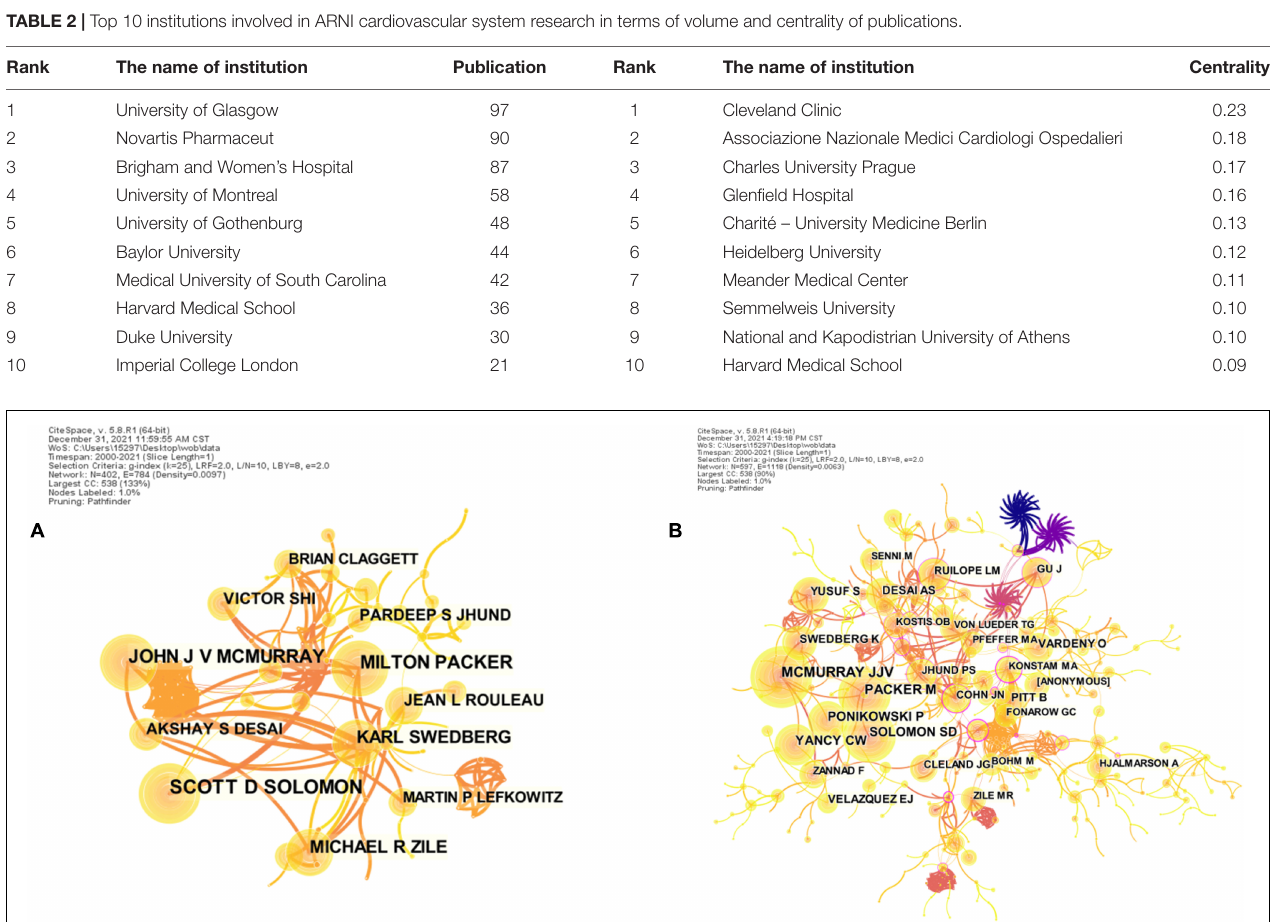
FIGURE 4 | CiteSpace visualization of the authors (A) and co-cited authors (B) involved in ARNI research in the cardiovascular system. Circle node represent author of papers; link between nodes represent partnerships.